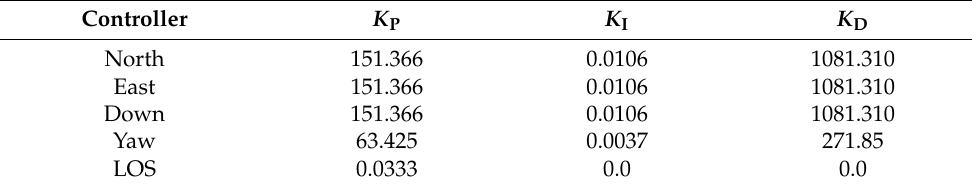
Table 3. PID controller parameters for the AUV.